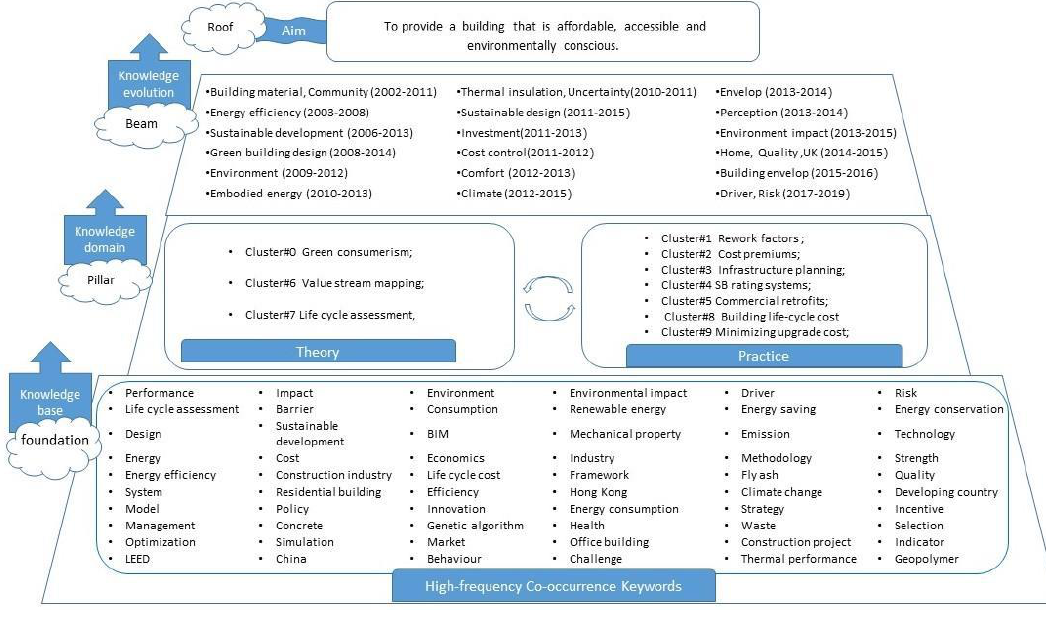
Figure 6. GBE knowledge map.